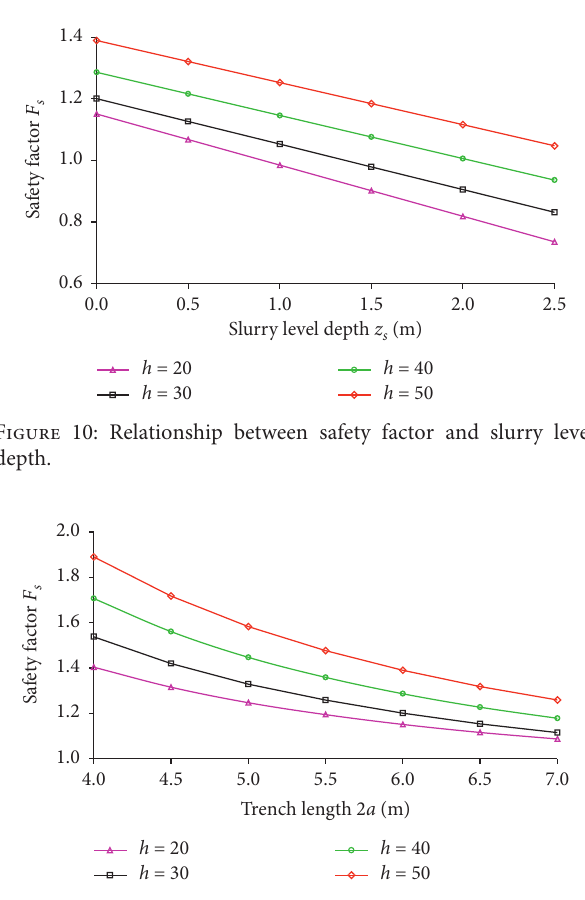
Figure 11: Relationship between the safety factor and trench